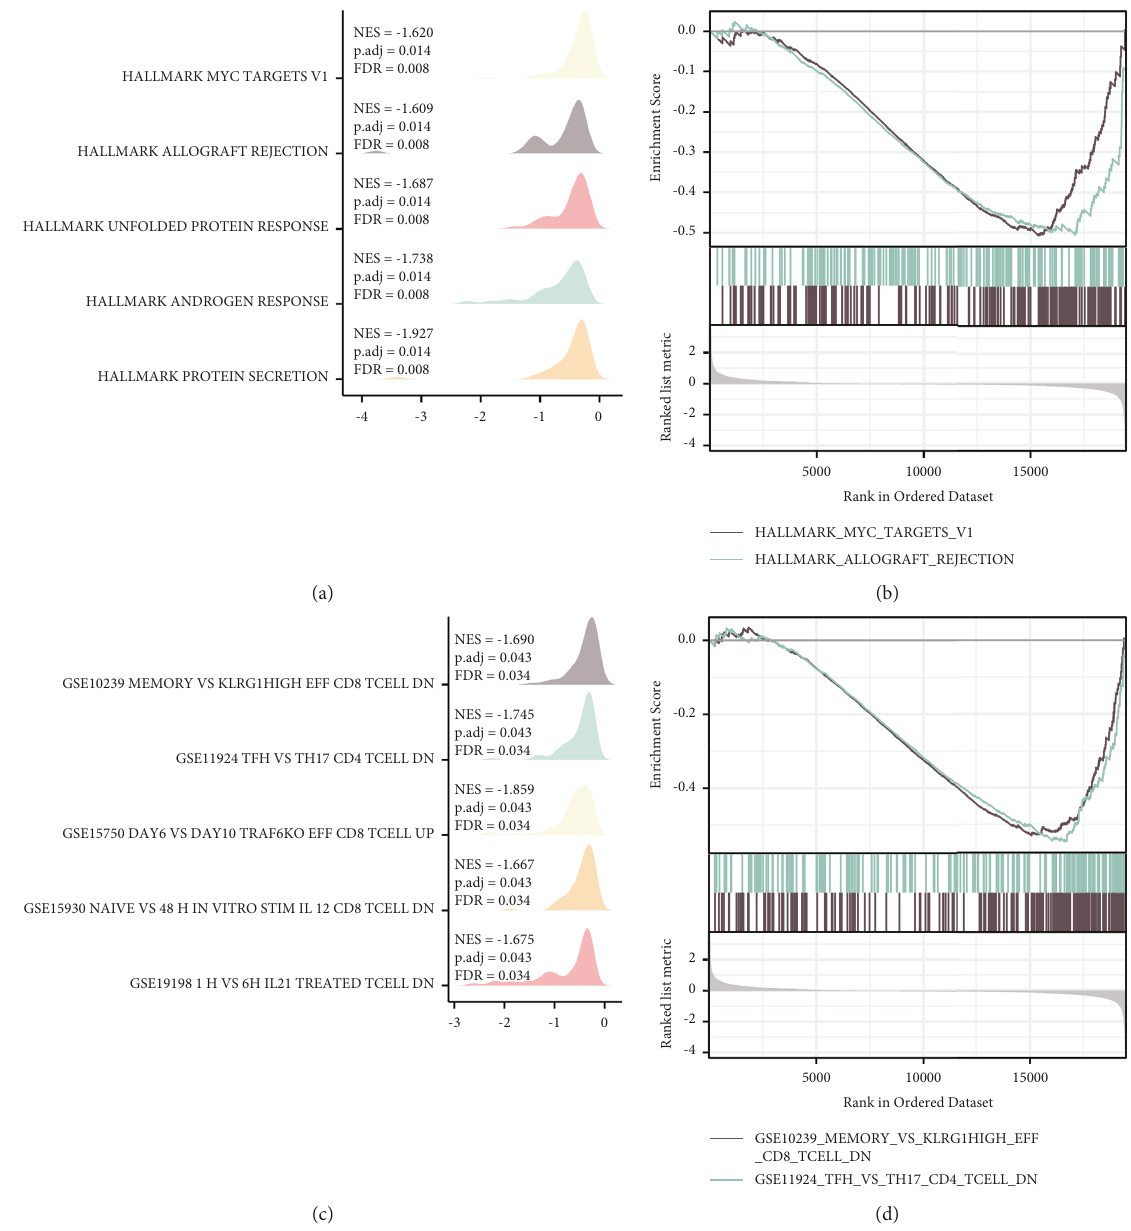
Figure 6: GSEA analyses between keloid samples expressing high and low levels of FGF11 (separated by 50% median) based on annotations from hallmark gene sets and c7: immunologic signatures from the molecular signatures